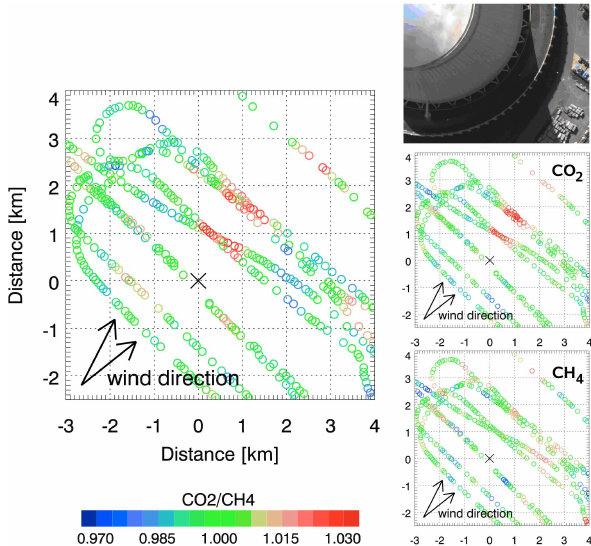
Fig. 13. As Fig. 12 but for the power plant Schwarze Pumpe located near the power plant J¨anschwalde. The CO 2 output of the power plant was 26tmin − 1 during the overflights (Vattenfall Europe Gen- eration AG&Co. KG, Cottbus, Germany, personal communication, 2008).